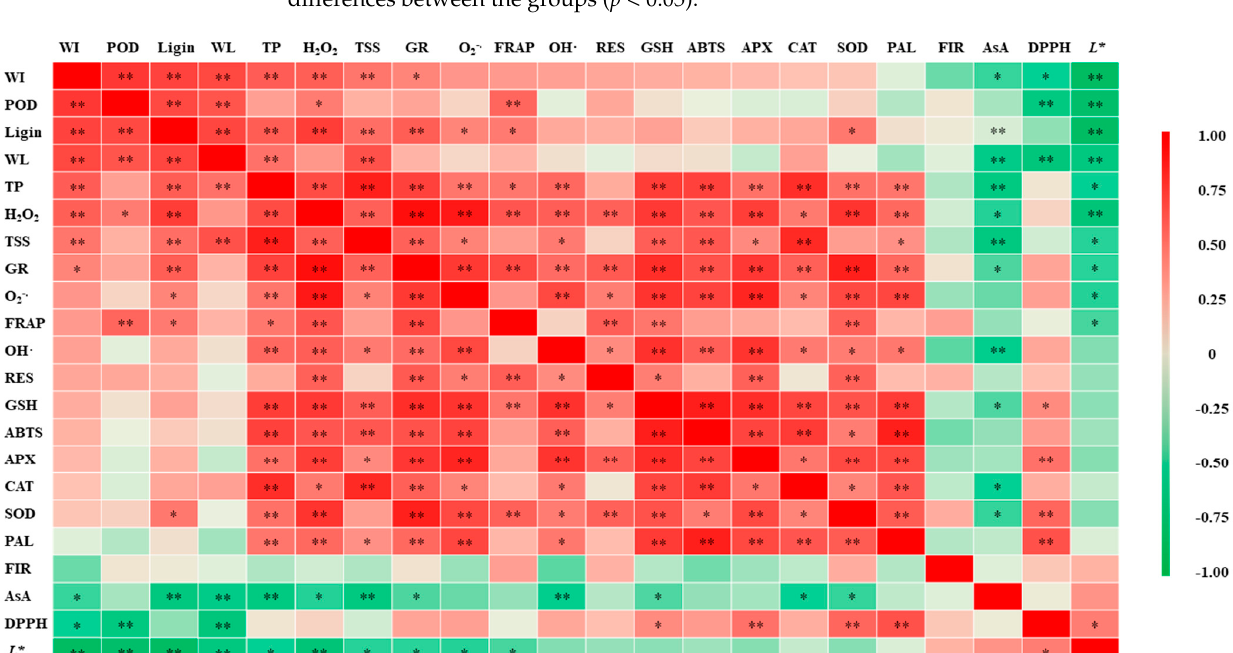
Figure 2. Effect of cutting methods on O 2 − · content ( a ) and H 2 O 2 content ( b ) in fresh-cut cucumbers. Vertical bars represent the standard deviation of the mean (n = 3). Different letters indicate significant differences between the groups ( p < 0.05).